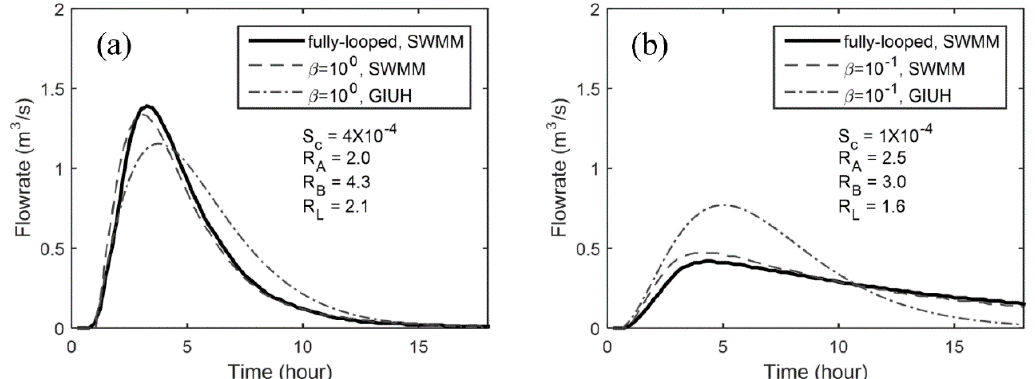
Figure 10. Comparison of the flow hydrographs from a fully looped network using Storm Water Management Model (SWMM) and a dendritic networks generated by the Gibbsian model using Geomorphologic Instantaneous Unit Hydrograph (GIUH) and SWMM (rainfall intensity = 15